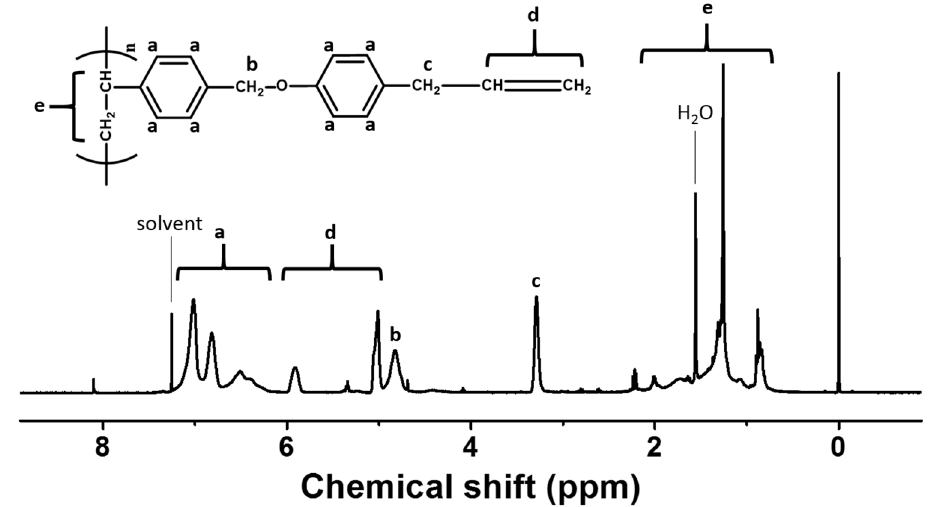
Figure 2. Proton nuclear magnetic resonance ( 1 H NMR) spectrum of PCHA100.